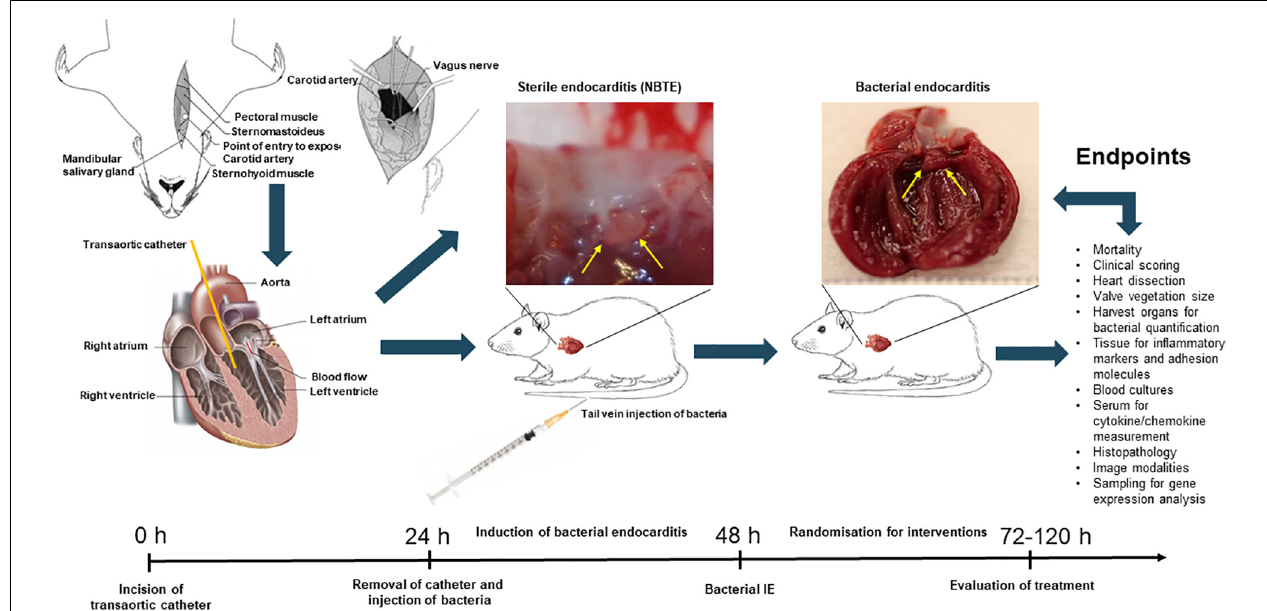
FIGURE 3 | Schematic overview of in vivo experimental endocarditis, here illustrated by the experimental model of rat endocarditis. Abbrevations: non-bacterial thrombotic endocarditis, NBTE; infective endocarditis, IE.